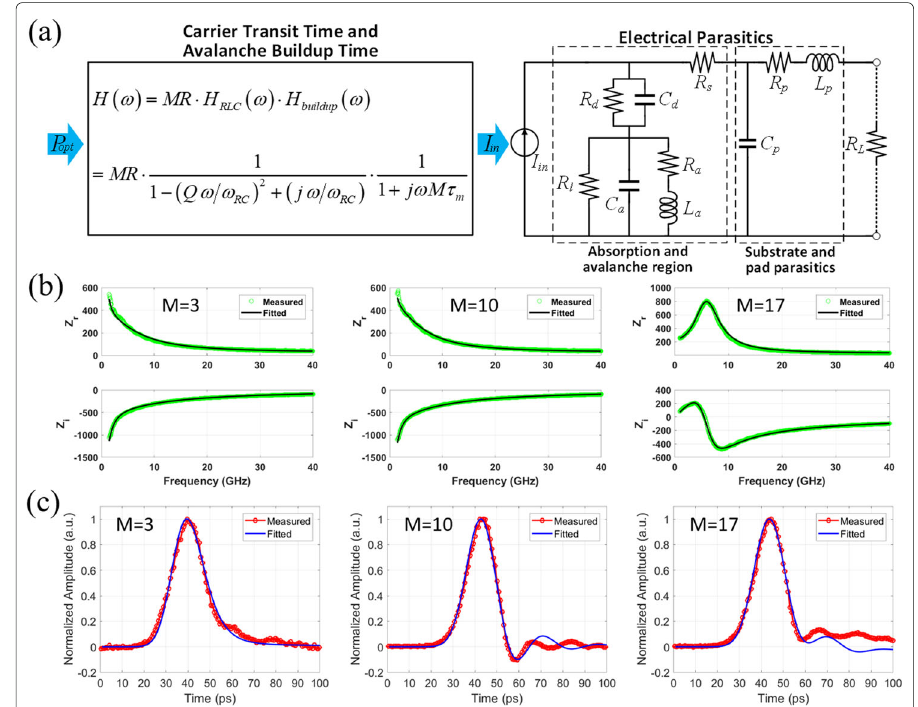
Fig. 12 a Si-Ge APD equivalent circuit model including the effects of carrier transit time and avalanche buildup time as well as electrical parasitics [61]; Measured and curve fitted b small signal and c impulse responses at various multiplication gains (or bias voltages) [40]